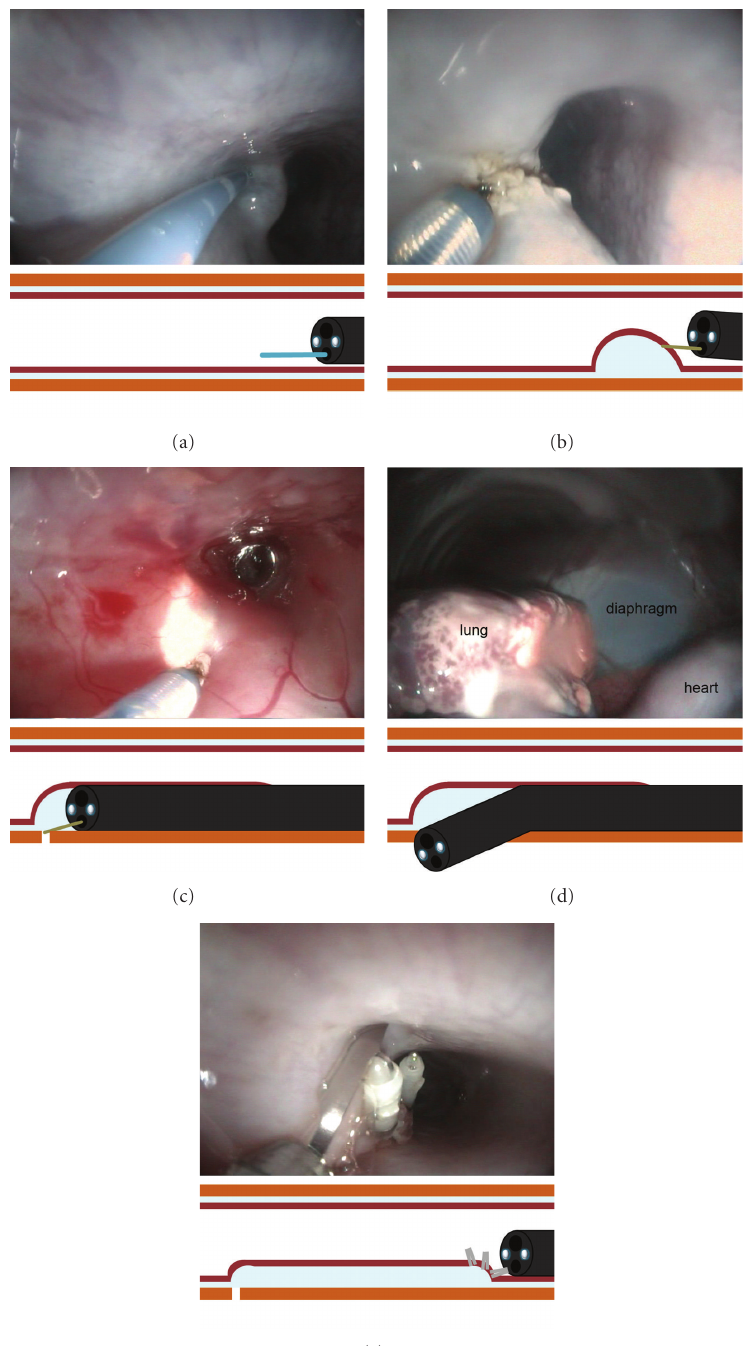
(e) Figure 1: Transesophageal submucosal endoscopy with mucosal flap (SEMF) in a porcine model. (a) Saline is injected into the submucosal layer of the esophagus. (b) The mucosa of the bleb is incised using a needle knife. (c) A 10cm tunnel is created using air and blunt dissection. The muscularis propria is incised at the distal end of the esophageal submucosal tunnel. (d) The endoscope is passed through the esophagotomy and the thoracic cavity is inspected. (e) Esophagotomy closure is achieved by mucosal flap adhesion. The mucosal defect is sutured using